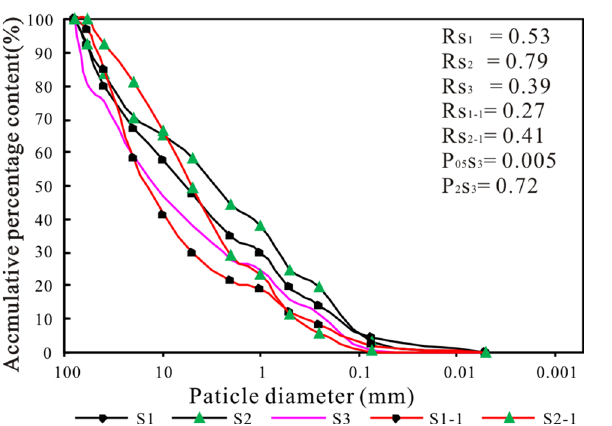
Figure 7. Particle size distributions of debris flow